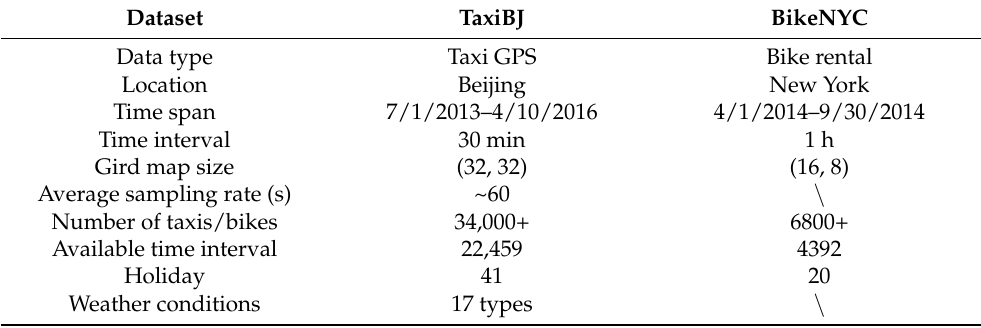
Table 2. Dataset